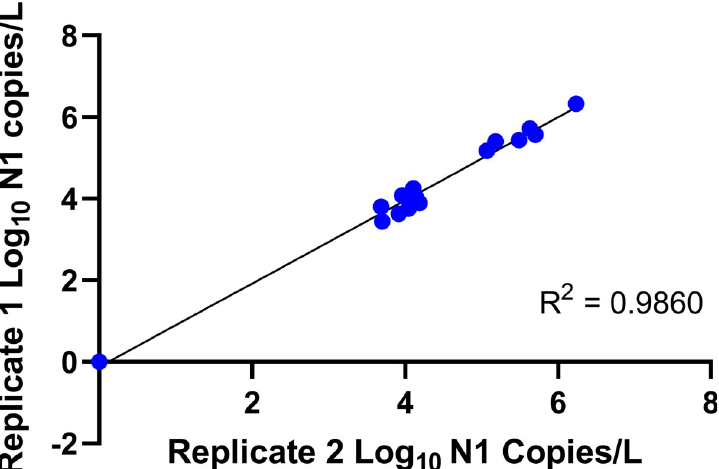
Fig 1. Repeatability of protocol: Pearson correlation of replicate measurements (n = 2) of copy number yield for the N1 target from fourteen 24-hr composite wastewater samples and a negative control, demonstrating the reproducibility of our protocol. Sample collection and initial processing was performed on the same day.